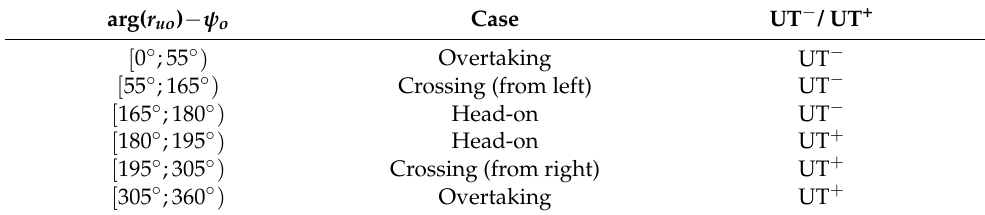
Table 3. How to choose direction of collision avoidance according to COLOREGS law.